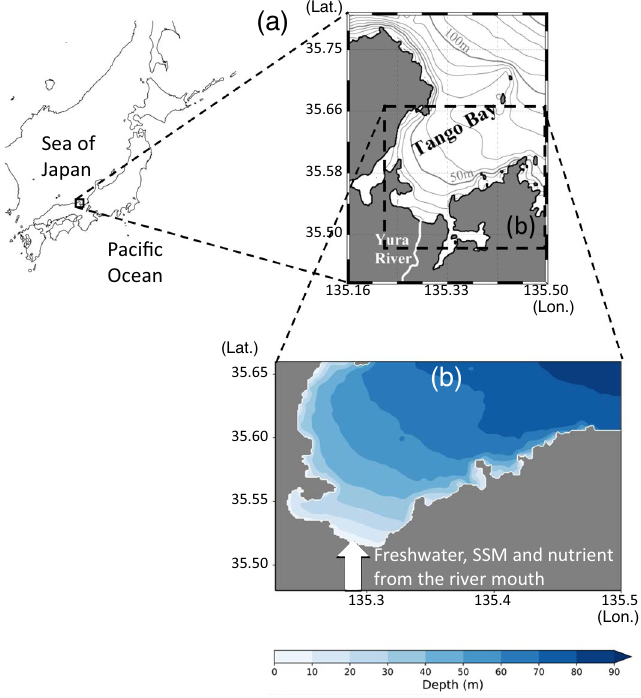
Figure 2. ( a ) Location and topography of Tango Bay and the Yura River, Japan. ( b ) Topography of the model domain, although a few small bays connected to the Tango Bay are treated as land-grids. We consider freshwater, SSM, and nutrients (nitrate) flowing from the southern river mouth into the sea (white arrow). This figure was prepared with matplotlib ver. 3.3.1 in Python ver. 3.7.6 and Microsoft Powerpoint 2013.